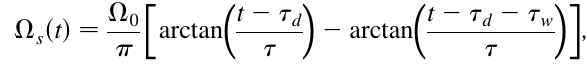
FIG. 2. Steady-state transmissions T detuning in the case of overcoupling. The solid blue line in- dicates the case for h ¼ 0 , the dashed red line for h ¼ 8 (cid:4) (cid:4) ex ¼ (cid:4) m